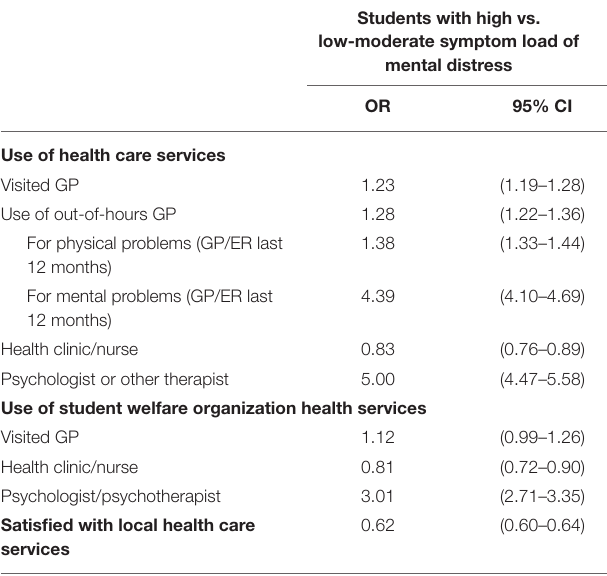
TABLE 3 | Binary associations between use of health services in students with high symptom load (avg. HSCL-25-score > 2) ( N = 12,576) vs. students